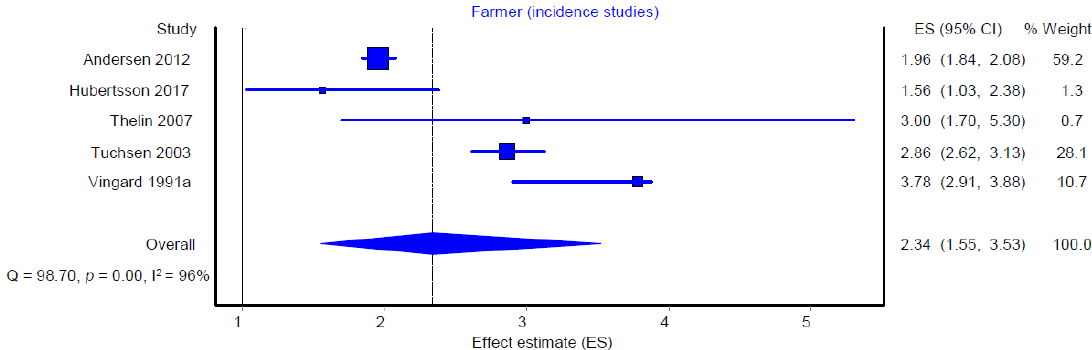
Figure 5. Meta-analysis of the risk of hip osteoarthritis among farmers in cohort studies (all incidence studies, n = 5).